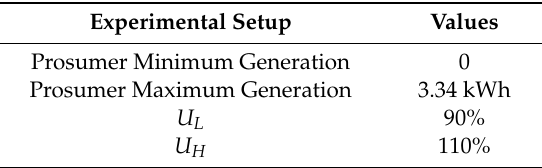
Table 1. Experimental setup for prosumers generation.